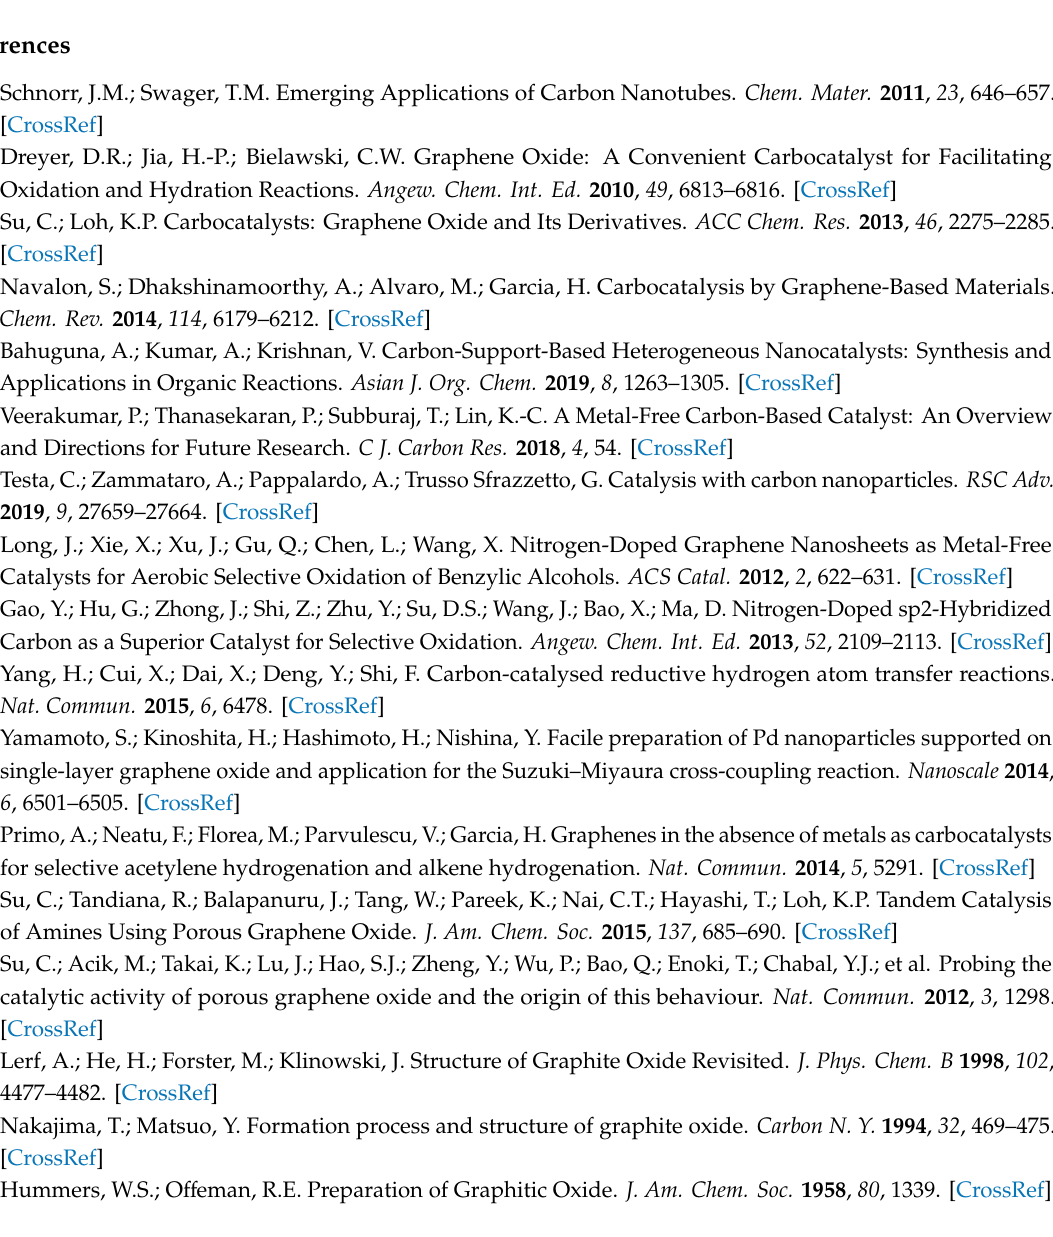
(10a), Table S1: Element composition obtained from the XPS analysis for UC materials, Table S2. Optimization of the reaction conditions for the synthesis of Xanthene a , Table S3. synthesis of 1,8-di-oxo-octahydroxanthenes derivatives using HUC as a catalyst, Scheme S1: Mechanism for HUC catalysed synthesis of chromene derivatives, Scheme S2: Mechanism for HUC catalysed synthesis of Xanthene